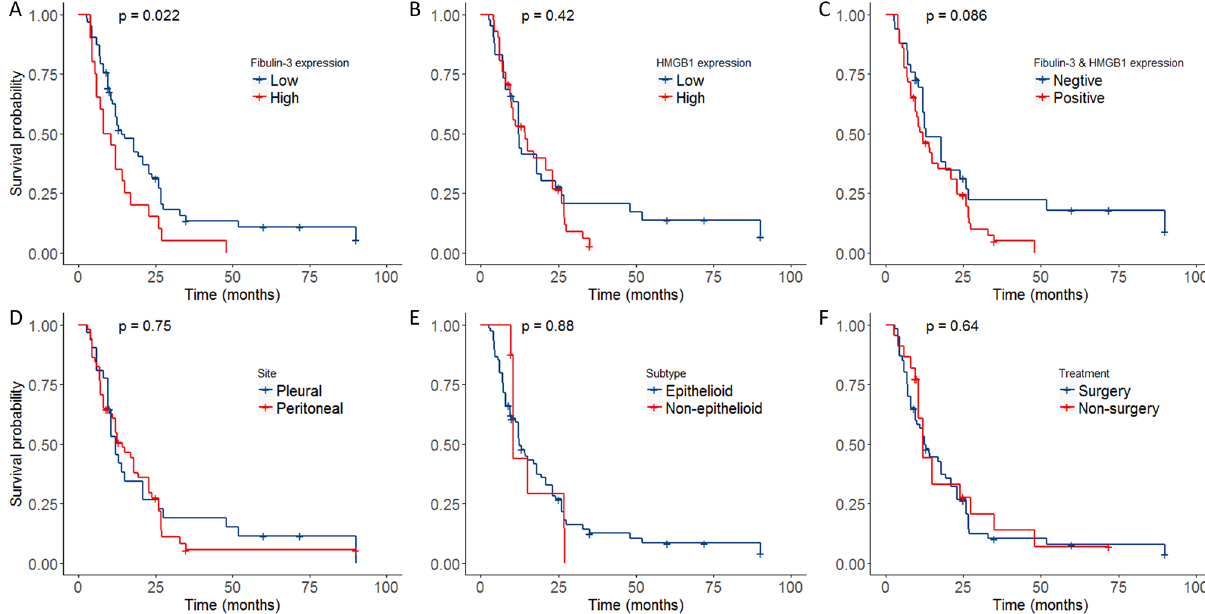
Figure 4. Survival plots of fibulin-3 and HMGB1 classified by tumor sites and tumor type. ( A ) Overall survival rate of mesothelioma patients. ( B ) Survival plot of different gender of mesothelioma patients. ( C ) Survival plot of different age of mesothelioma patients. ( D ) Survival plot of different histological subtype of mesothelioma patients. ( E ) Survival plot of different site of mesothelioma patients. ( F ) Survival plot of different treatment of